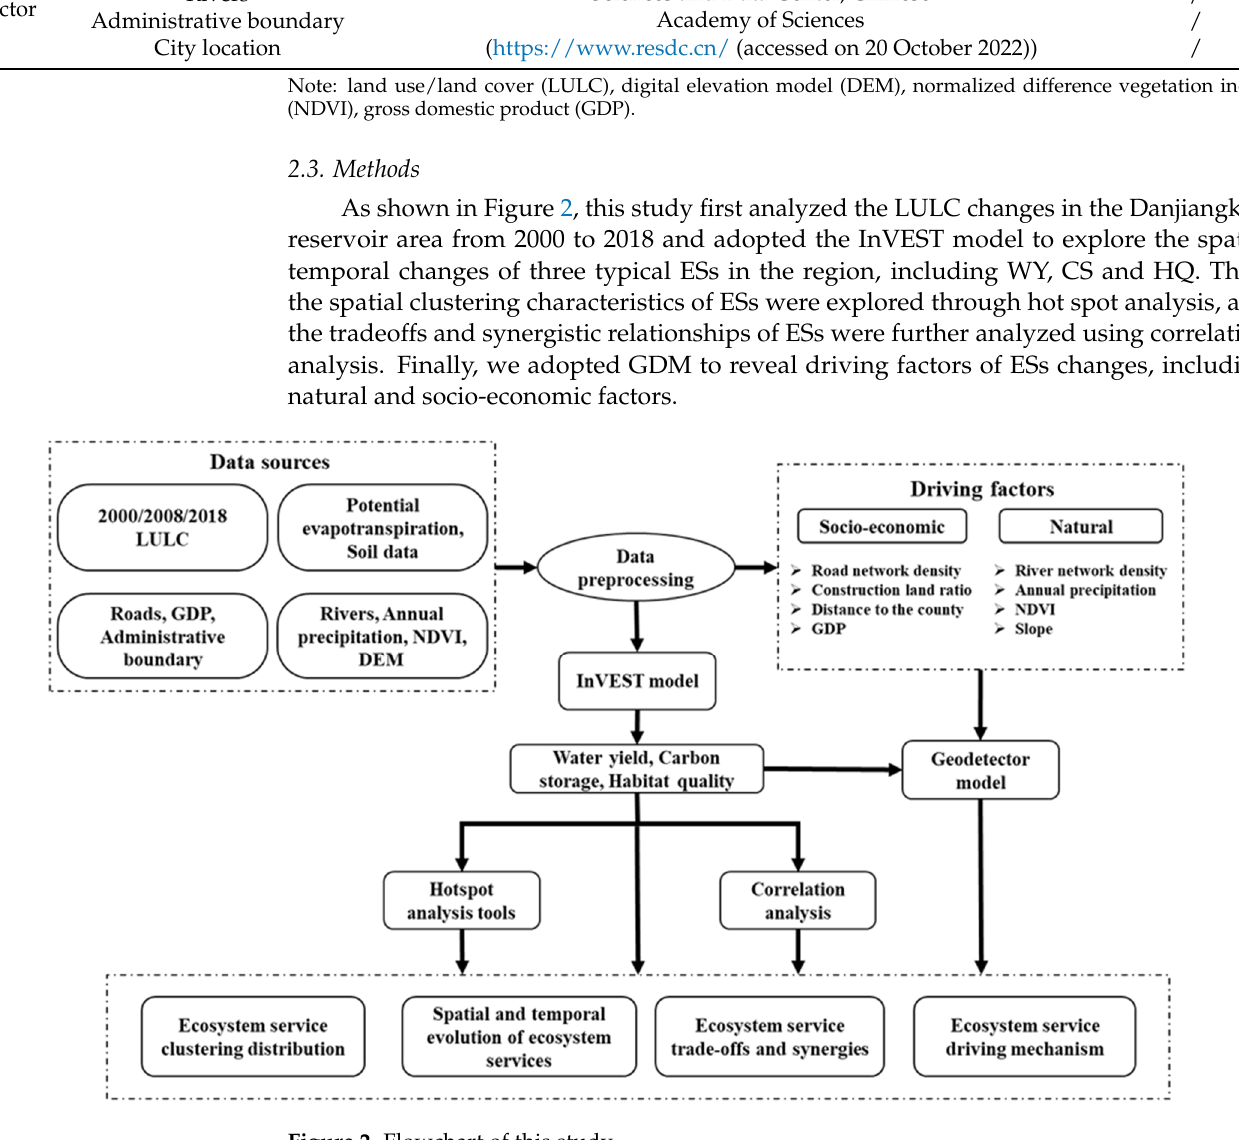
Table 1. Data sources for this study.